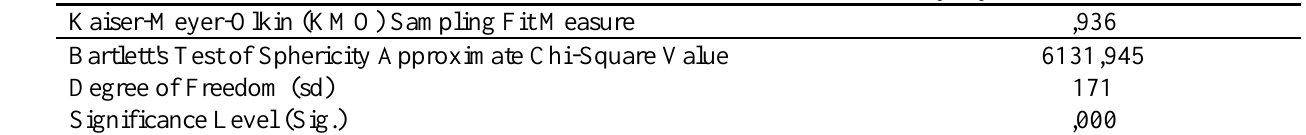
Table 4. KMO and Bartlett's test statistics for customer loyalty scale